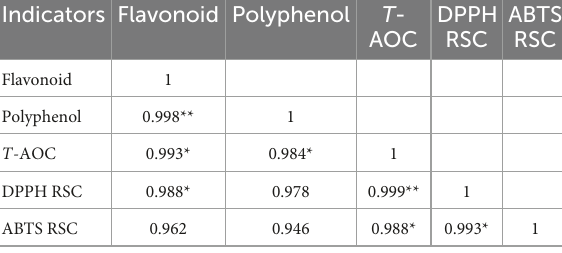
TABLE 4 Correlation analysis of free polyphenols (FP) and flavonoids (FF) content and antioxidant activity of mung bean sprouts. Indicators Flavonoid